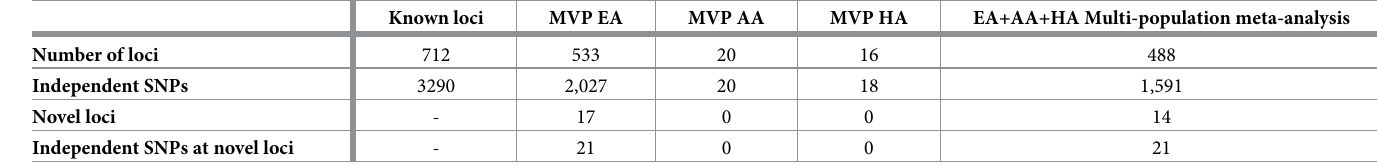
Table 3. Summary of race/ethnicity-specific and multi-population meta-analysis genome-wide association study results. Known loci MVP